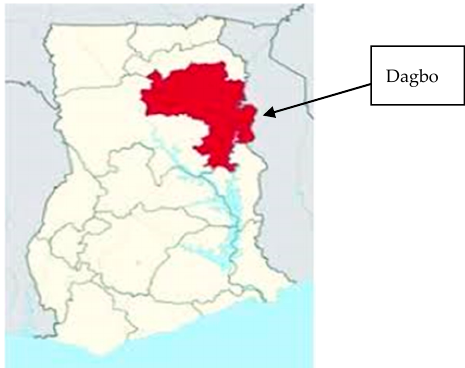
Figure 1. Map of Ghana showing Dagbon and the geographical scope of the research area (Source: Survey Department of Ghana, Accra, 2019).